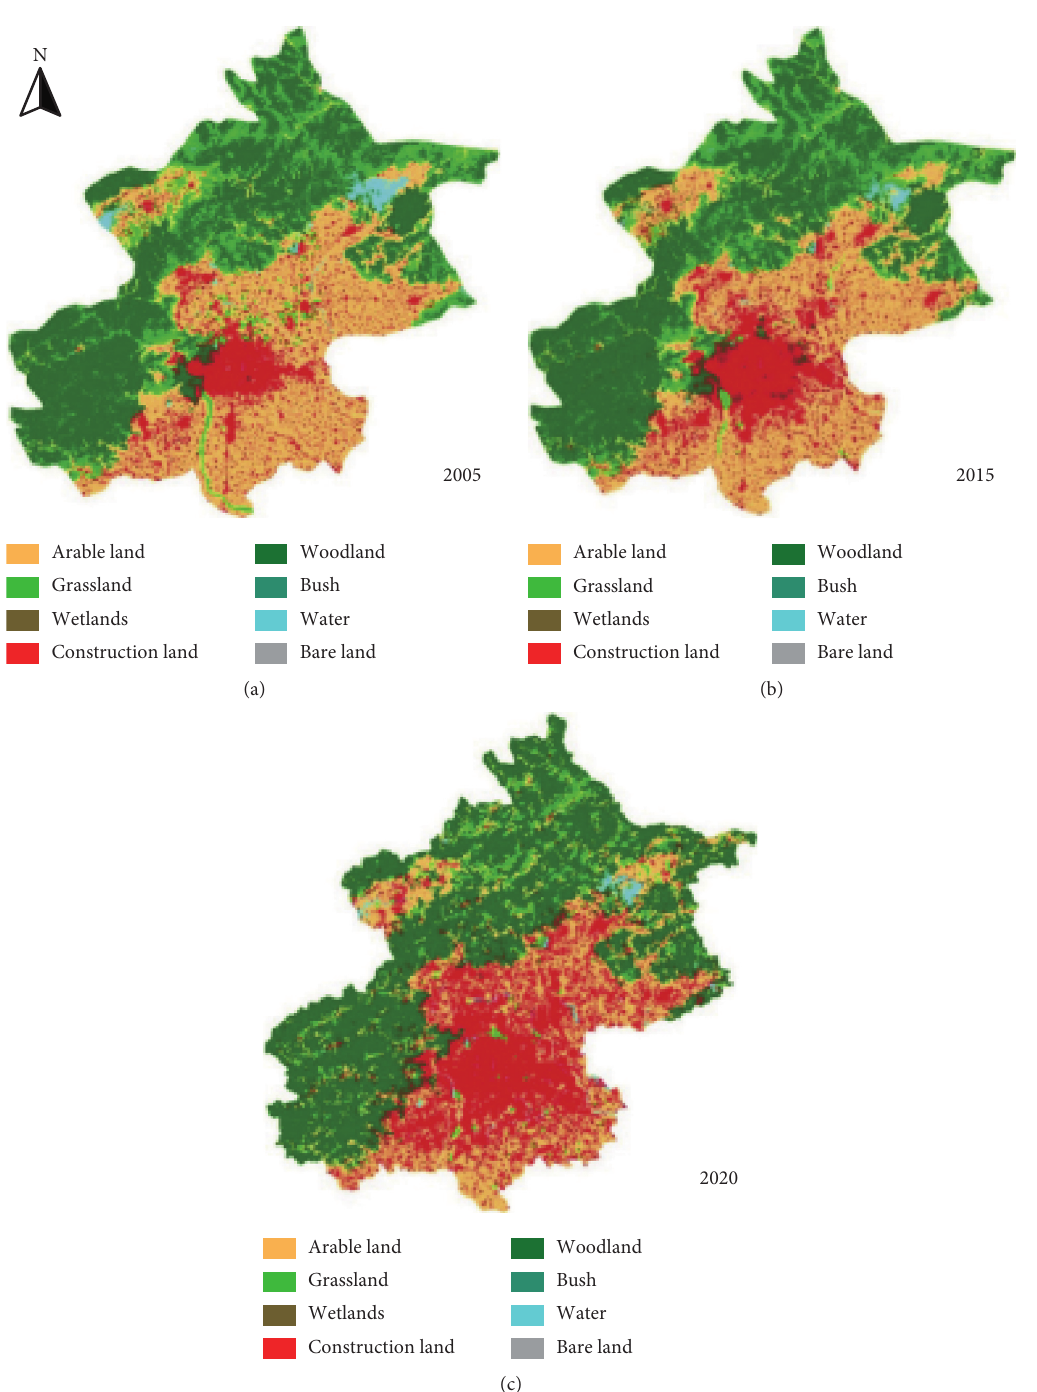
Figure 6: Distribution map of landscape